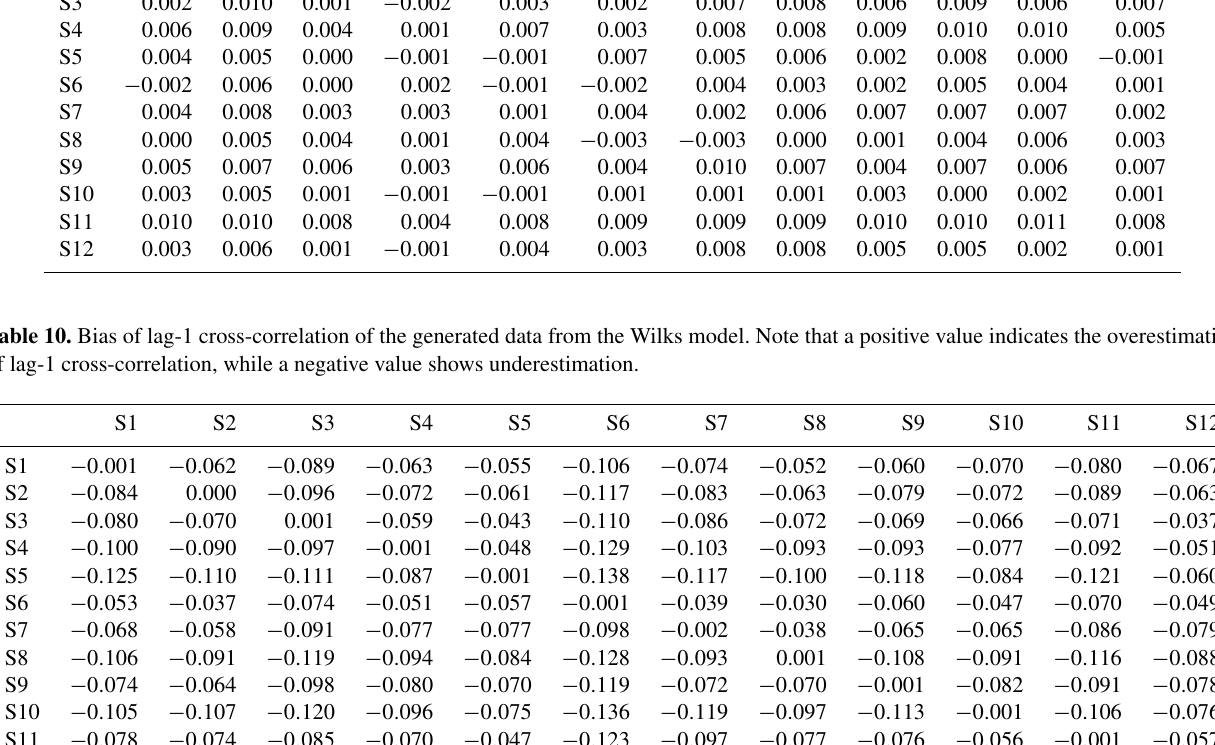
N P (cid:48) G m − (cid:48) h , and see Eq. (18) for the details m = 1